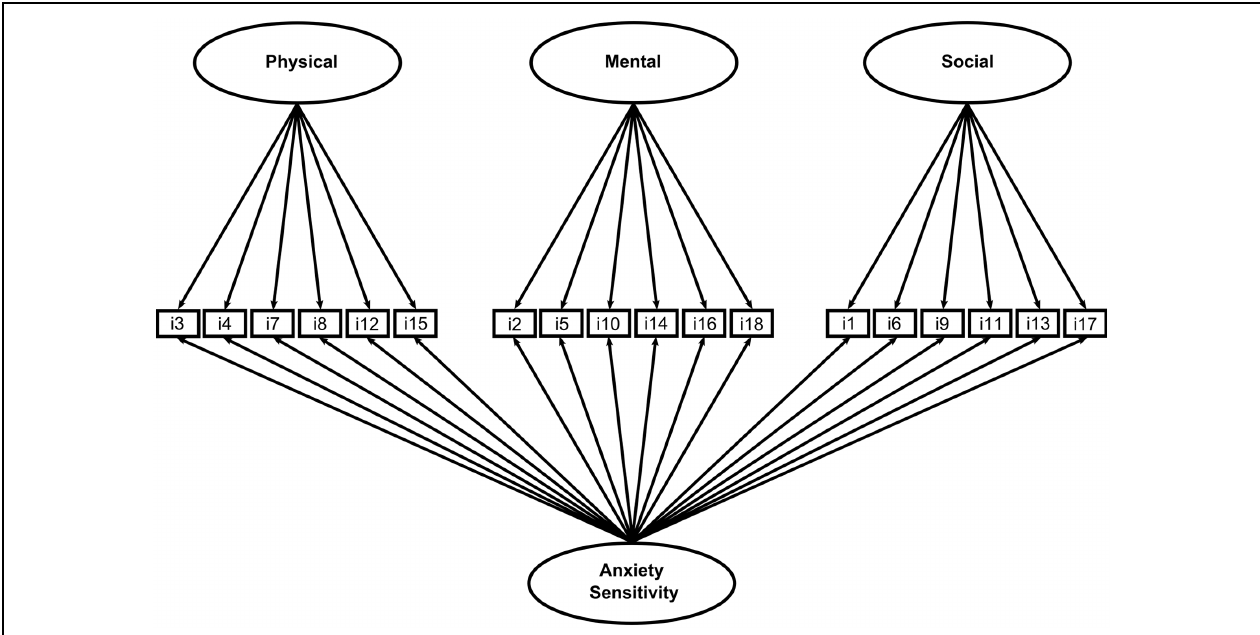
FIGURE 1 | Factor structure of the